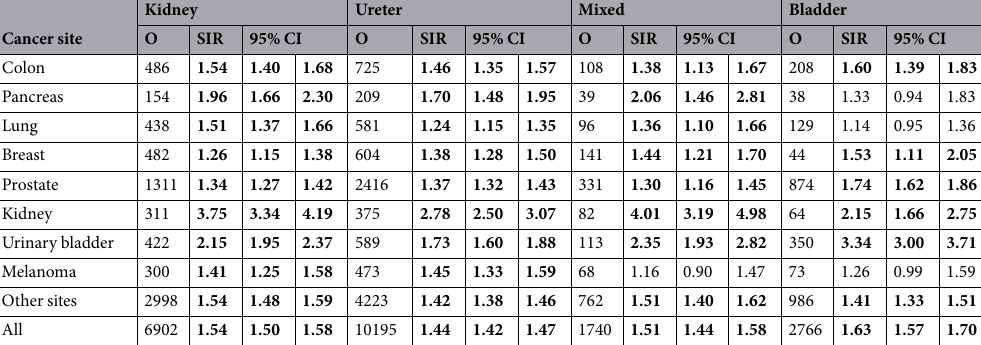
Table 1. SIR for cancer of patient with urolithiasis, 1987–2012. Bold type: 95% CI does not include 1.00. O = observed number of cases; SIR = standardized incidence ratio; CI = confidence